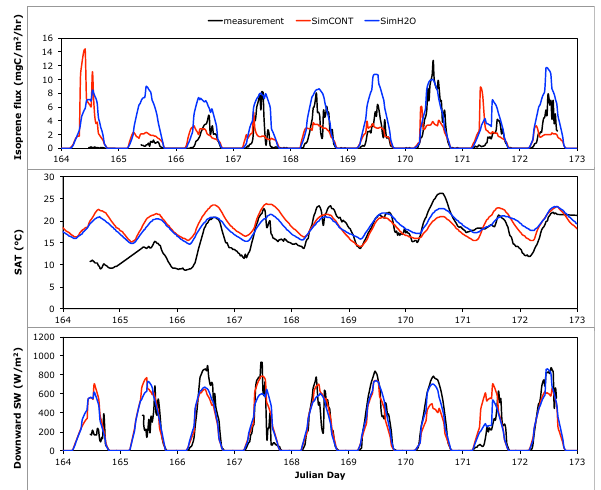
Figure 8c. Results for Harvard Forest during June 13-22 2007. Fig. 8c. (a–e) Time evolution of isoprene emission flux, surface air temperature (SAT) and downward shortwave (SW) radiation at the temperate measurement sites. Measurements are shown in black (where data is available). Model climatological results are averages of 10 simulation years in SIMCONT (red) and SimH2O (blue). (c) Harvard Forest during 13–22 June 2007.